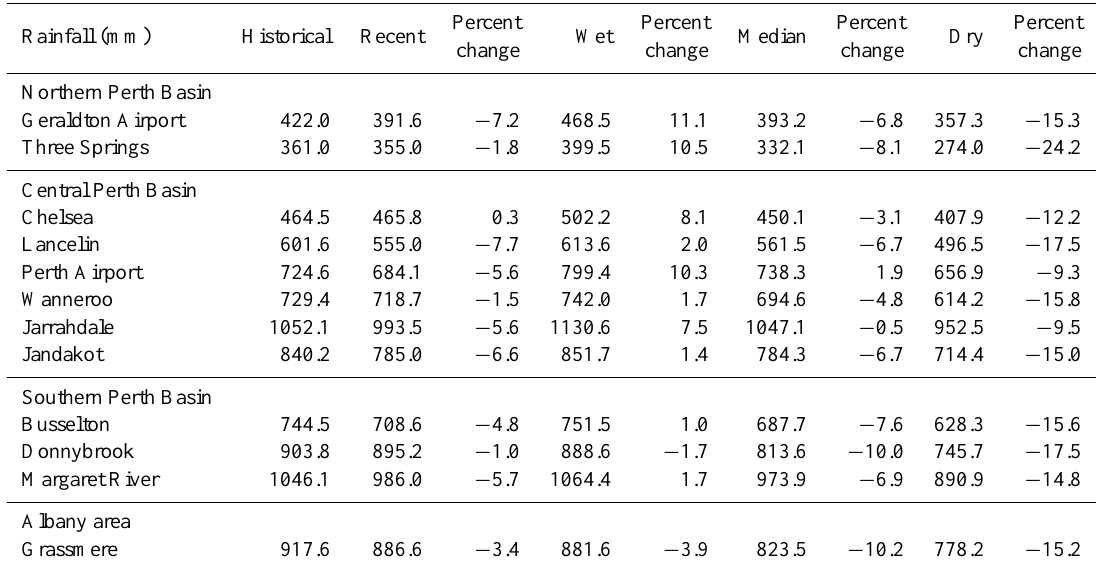
Table 1. Average annual rainfall (mm) for stations in study area, and deviation from historical record. Historical climate is from 1975–2007; recent climate is from 1997–2007; dry climate is from a future simulation derived from INMCM +1.3 ◦ ; median climate is from a future simulation derived from MIROC +1.0 ◦ ; wet climate is from a future simulation derived from GFDL +1.3 ◦ .